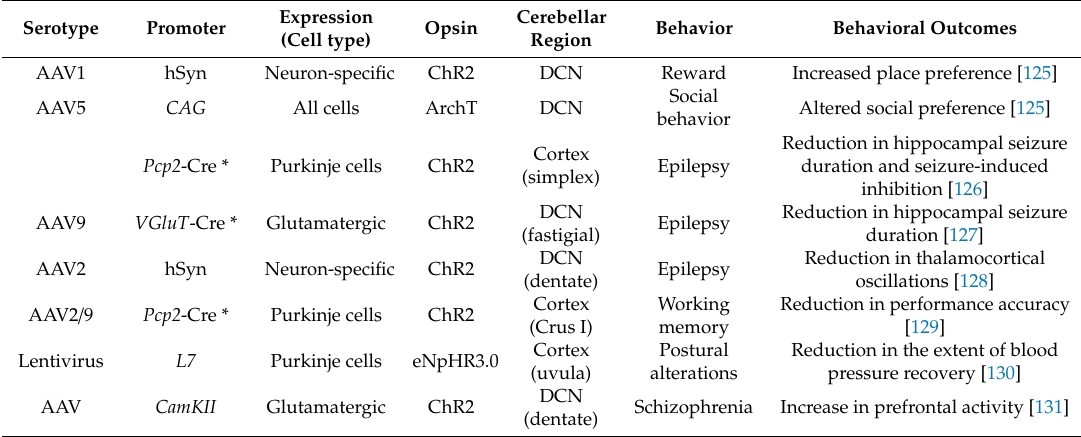
Table 1. Viral constructs used in optogenetic manipulation of non-motor